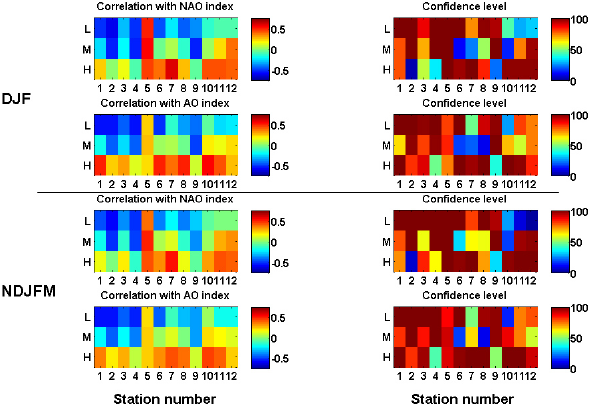
Figure 7. Correlation of low (L, intensity<0.34mm/3h), medium (M, 0.34<intensity<1.7mm/3h) and high (H, inten- sity>1.7mm/3h) intensity precipitation events (left column) with the NAO and AO indices over the 12 radar stations. The top two rows show results for the DJF months, and the bottom two rows show results for the NDJFM months. At right, columns shows con- fidence levels (0–100%) at which the observed correlations are sig- nificant.